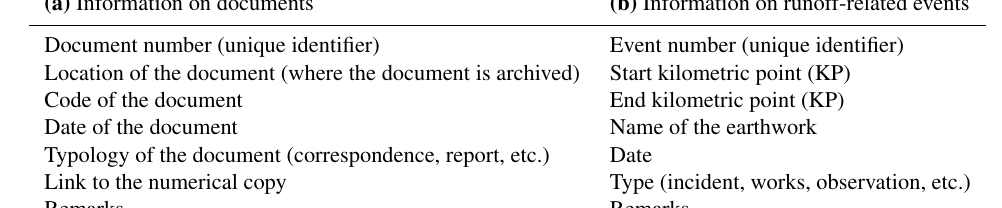
Table 4. Information collected on the documents collected in the archives on runoff-related impacts (a) and on the events related to runoff (b) .